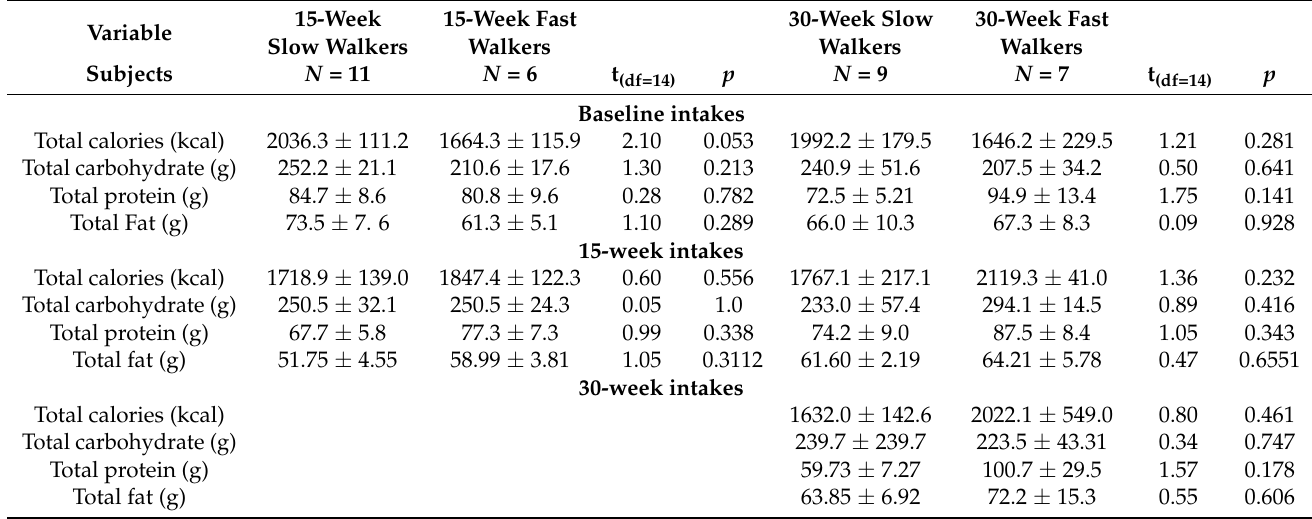
Table 7. Dietary intake as a function of 15-week and 30-week